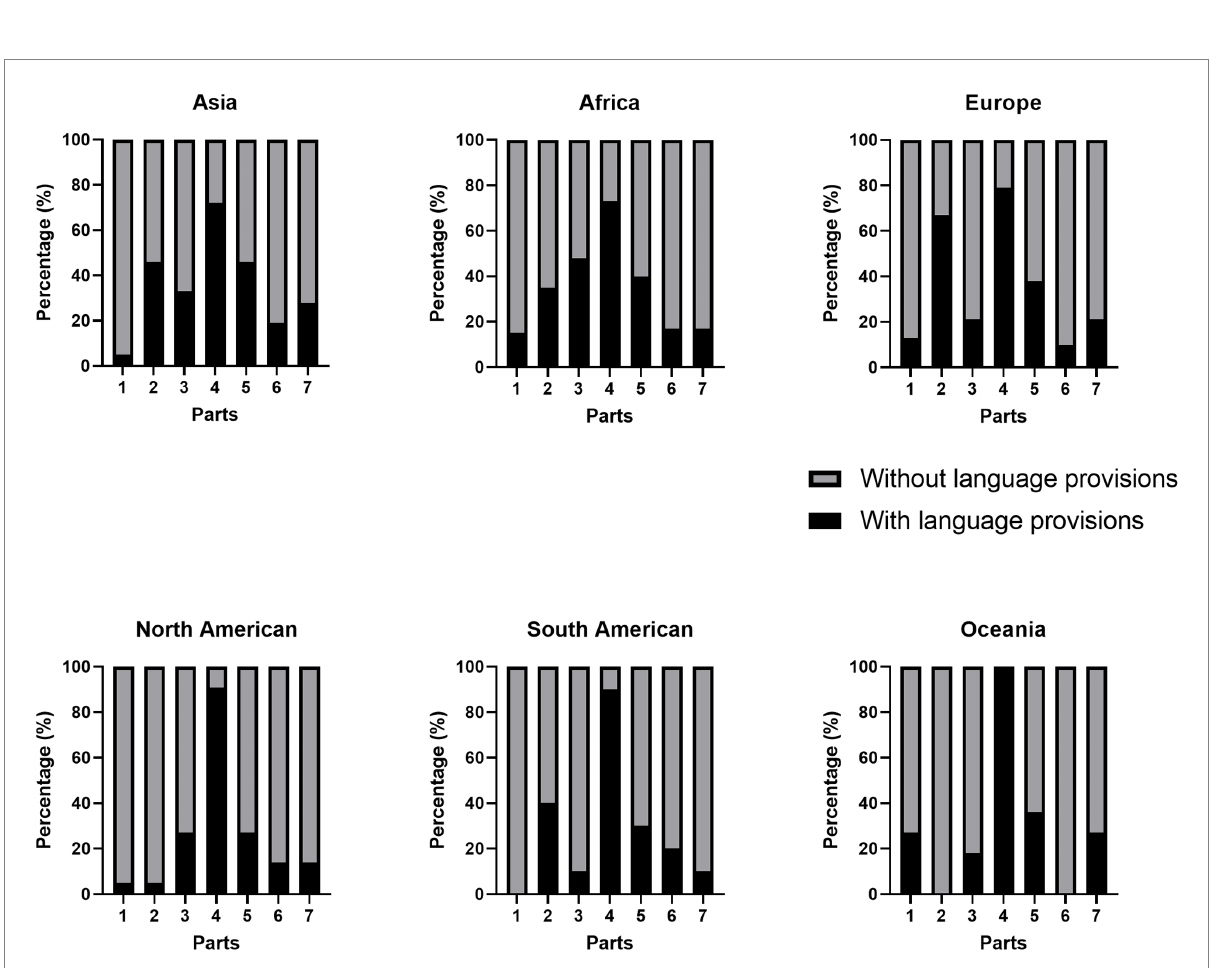
FIGURE 3 Distribution of language provisions across six continents. “1” = PR; “2” = GP; “3” = TS; “4” = RD; “5” = SA; “6” = NO; “7” =